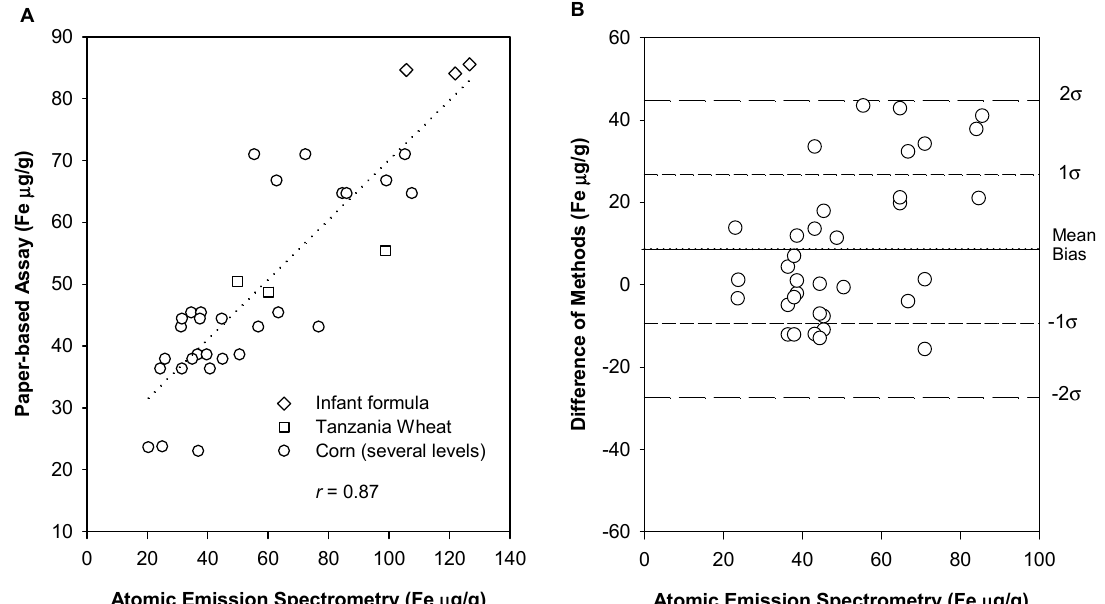
Figure 5. ( A ) Method comparison plot between the gold standard method and the paper-based assay for samples low ( n = 9), medium ( n = 9), and high ( n = 8) in ferrous fumarate fortified corn flour, Tanzanian wheat flour ( n = 3), infant formula ( n = 3), and unfortified corn flour ( n = 3). The Pearson coefficient ( r = 0.87) indicates a high positive linear relationship [28]. ( B ) Bland–Altman plot. All but 1 data point are within 2 σ and the majority of data points (71%) are within 1 standard deviation.